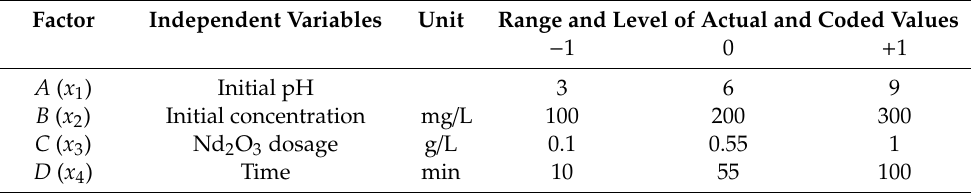
Table 1. Experimental range and levels of the independent process parameters tested. Factor Independent Variables Unit Range and Level of Actual and Coded Values